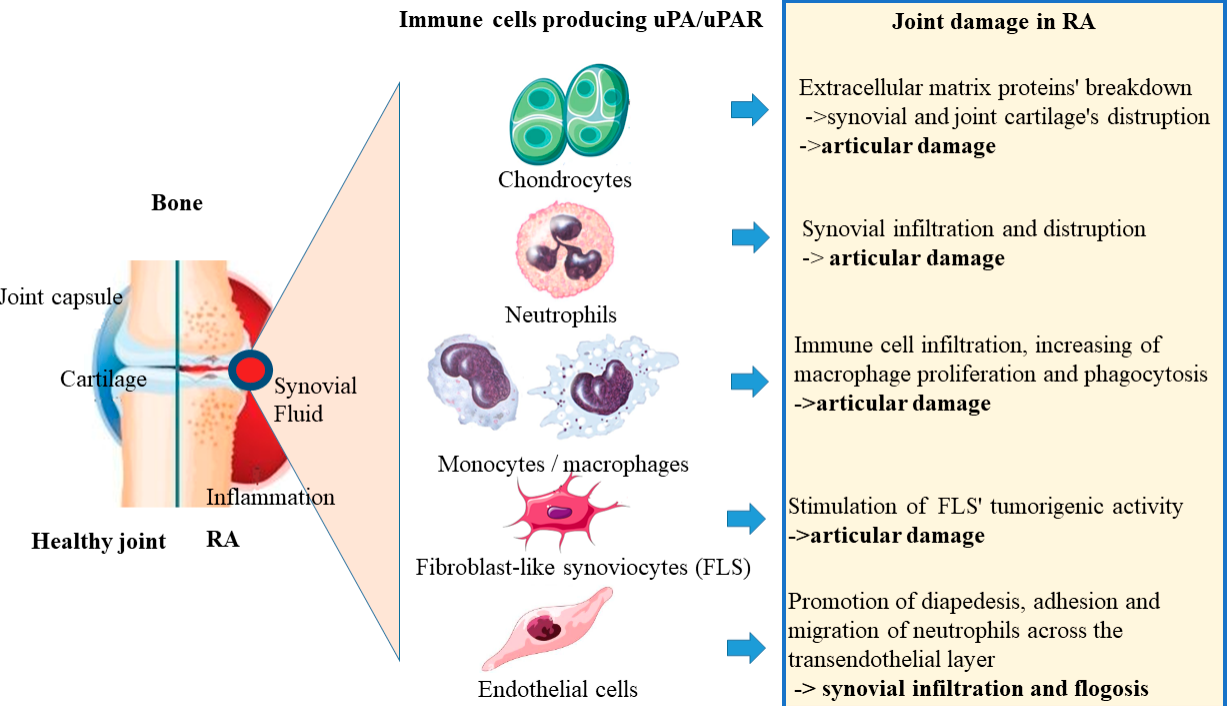
Figure 2. Immune cells producing uPA/uPAR as articular chondrocytes, neutrophils, monocytes, FLS, and endothelial cells produce high amounts of uPA in the RA microenvironment during RA disease condition, promoting articular damage, synovial infiltration, and phlogosis in the joint. Table 1. Cell types, pathways activated, and effect of uPA/uPAR signaling on Rheumatoid Arthritis [33–36].